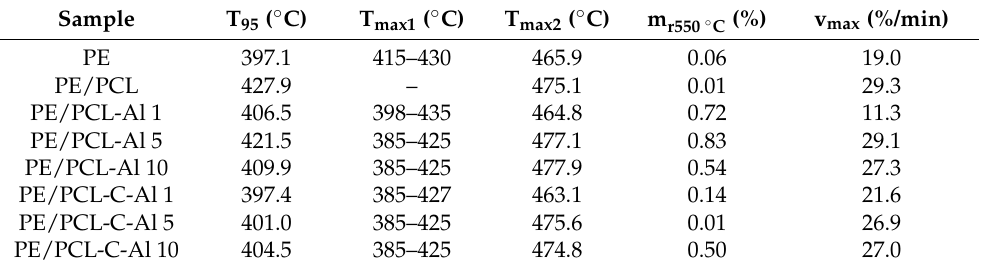
Table 1. Decomposition beginning temperature (T 95 ), the temperature at the maximum degradation rate (T max ), the char residue (m r550 ◦ C ), and the maximum degradation rate (v max ) of PE/PCL bilayer films.